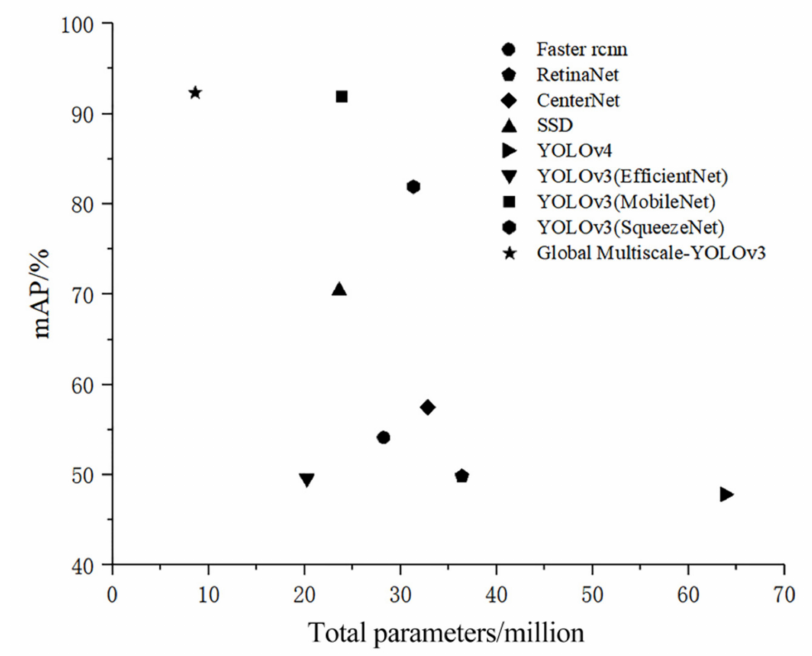
Figure 10. The relationship between mAP and the total parameters of the model.